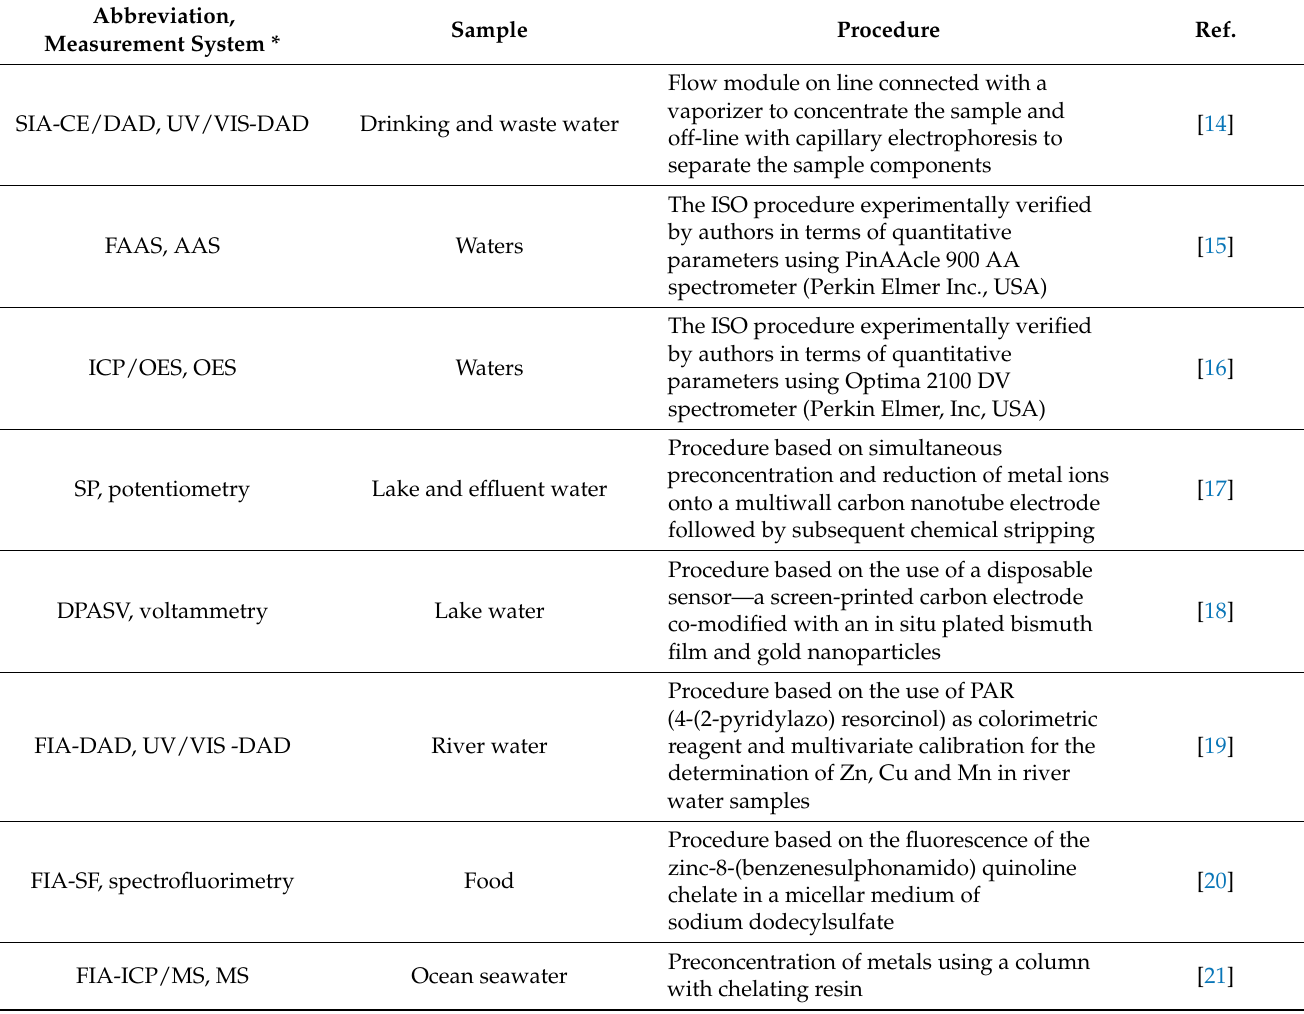
Table 1. The analytical methods studied in this